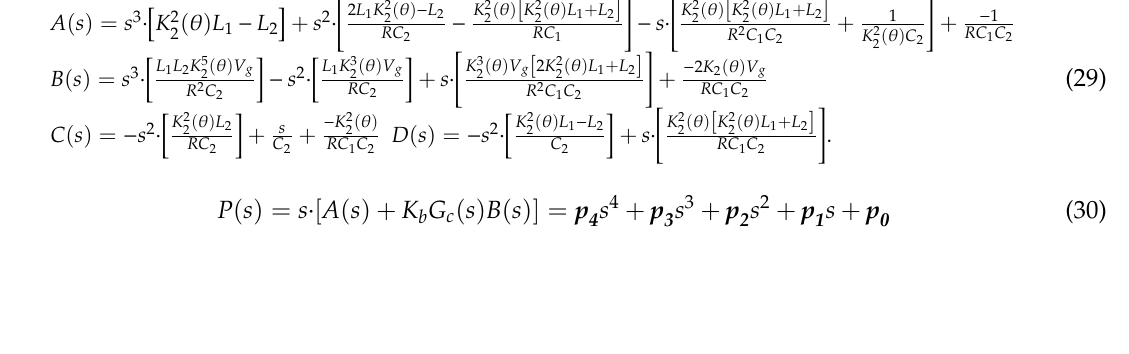
of the variation of the input current reference amplitude, as in the input current surface.